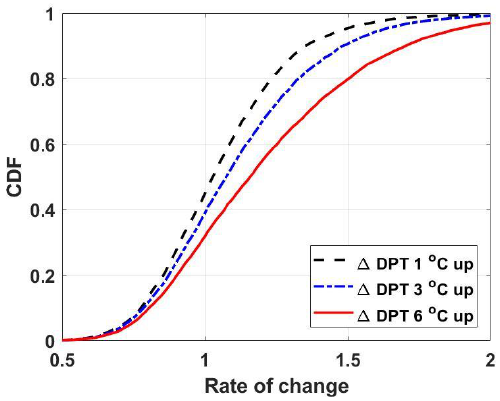
Figure 9. Cumulative distribution of rate of change with various DPT increase scenarios at the Cheonan site.